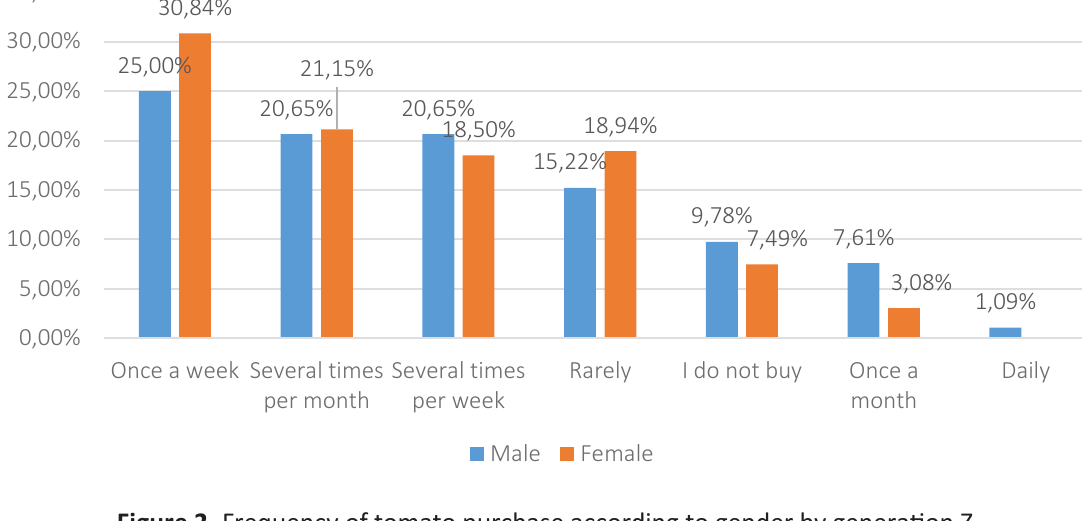
Figure 2. Frequency of tomato purchase according to gender by generation